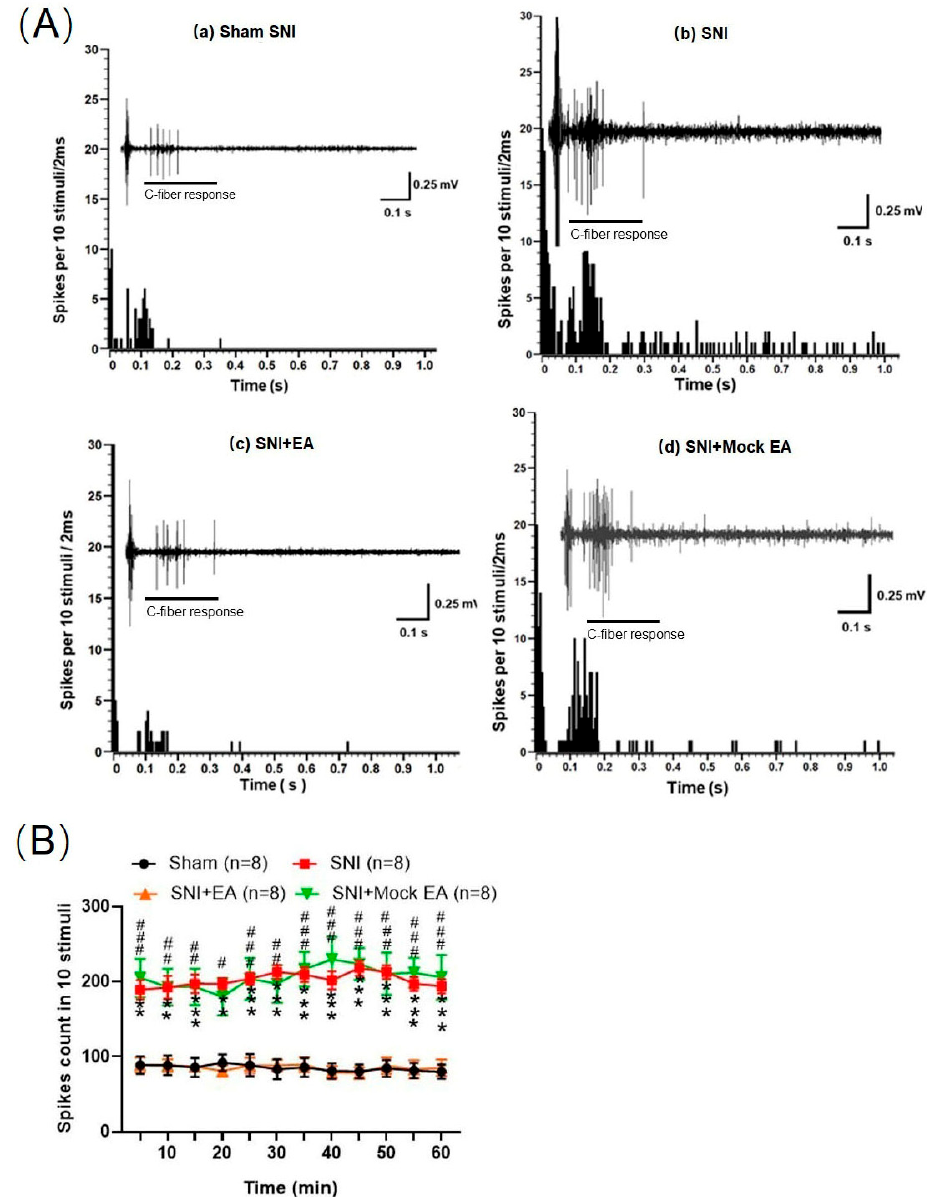
Figure 6. Effects of 2 Hz EA treatment on the C-fiber responses of dorsal horn wide dynamic range (WDR) neurons in SNI rats. ( A ) The original recording on the C-fiber-evoked discharges of a WDR neuron before and after 2 Hz EA treatment in SNI rats. a: Representative C-fiber responses of dorsal horn WDR neurons in the sham group; b: SNI, spared nerve injury surgery; c: SNI+EA, 2 Hz EA treatment; d. Mock EA+SNI, EA only stimulates acupoints, no electrical stimulation. ( B ) The total spikes count of the electrically evoked C-fiber responses in 10 stimuli. ** p < 0.01, *** p < 0.001, compared to the sham group. # p < 0.05, ## p < 0.01, ### p < 0.001, compared to the SNI group, respectively. Two-way ANOVA followed by Bonferroni’s post-hoc test, n = 8 per group.